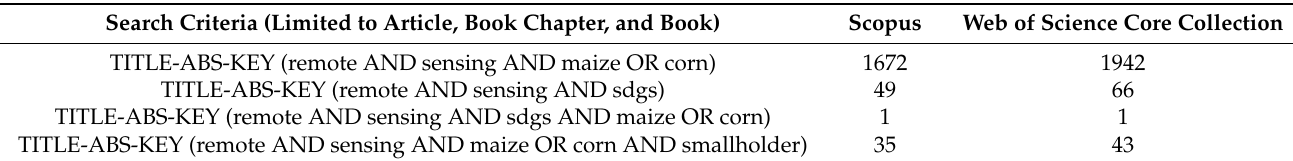
Table 1. A bibliometric search result of common result phrases and the associated number of documents retrieved. Time limit was not used in the search criteria. Search Criteria (Limited to Article, Book Chapter, and